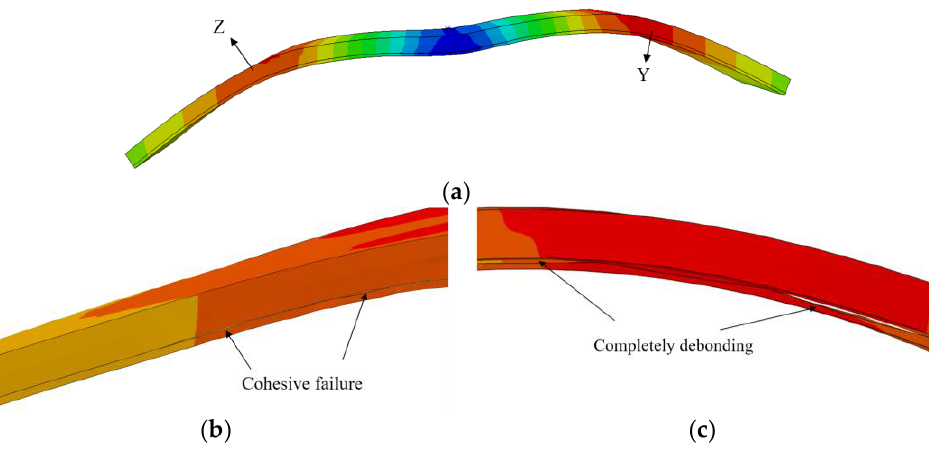
Figure 16. Debonding simulation of layers: ( a ) Displacement cloud map; ( b ) Cohesive failure; ( c ) Completely debonding.